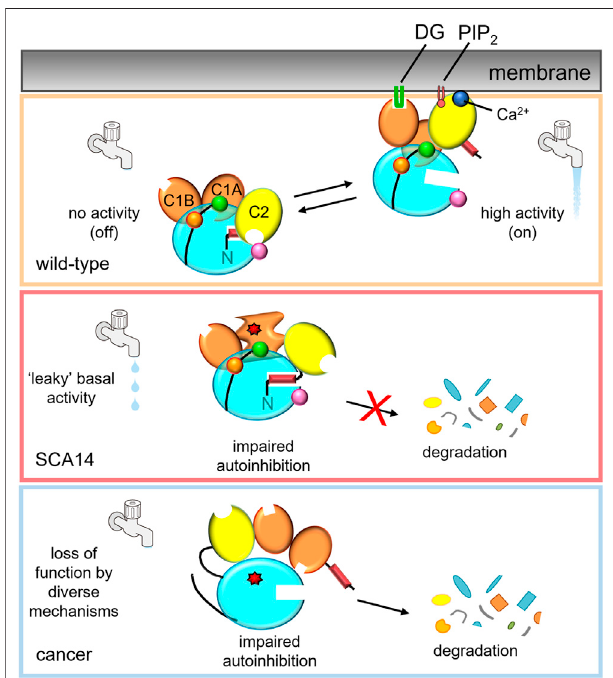
FIGURE2| PKC γ mutationsindiseaseleadtodifferingeffectsonkinase activity.Top: In the absence of second messengers, wild-type PKC γ adopts an autoinhibited conformation, in which no signaling occurs (water faucet is “ off ” ). In the presence of Ca 2+ and DG, wild-type PKC γ adopts an open conformation and is activated (water faucet is “ on).Middle: Mutations in SCA14 lead to impaired autoinhibition of PKC γ resulting in “ leaky activity ” ; mutations in the C1 domains protect PKC from down regulation, evading quality control degradation of the impaired PKC. This species can be further activated by second messenger binding for some, but not all, SCA14 mutations (not shown). Bottom: Mutations in cancer lead to loss of PKC function by diverse mechanisms. One common mechanism is by impairing autoinhibition, resulting in the dephosphorylation and degradation of PKC. Mutant PKC γ can also act in a dominant negative manner to suppress signaling by other PKC isozymes.